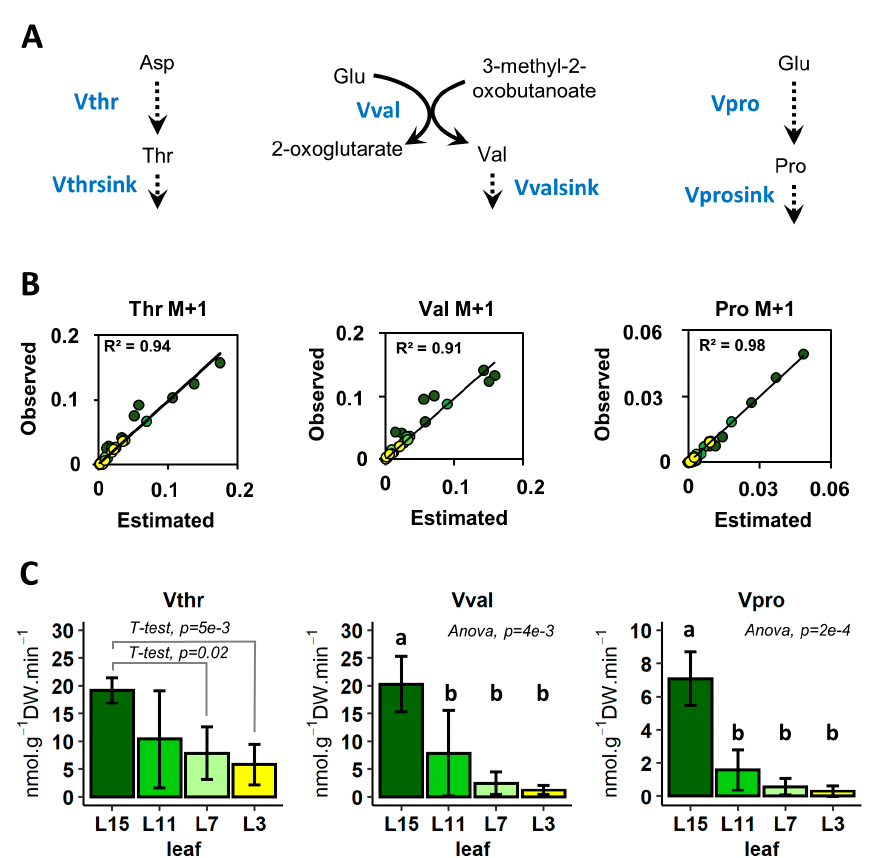
Figure 5. Estimation of metabolic fluxes for Thr, Val and Pro biosynthesis in leaf ranks with a different sink/source balance by using a 15 N-INST-MFA approach. ( A ) Metabolic subsystems considered for